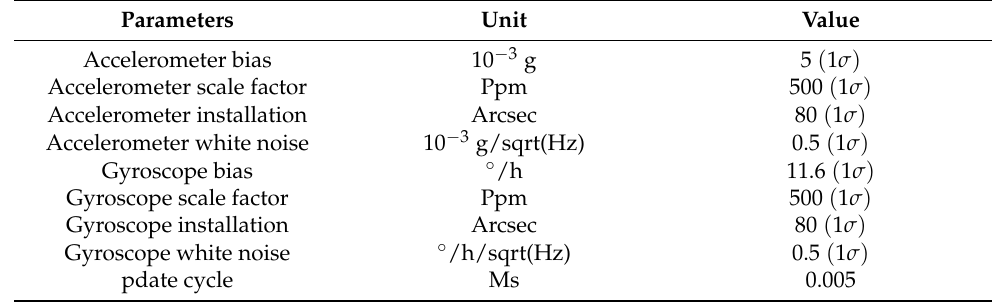
Table 1. Parameters of